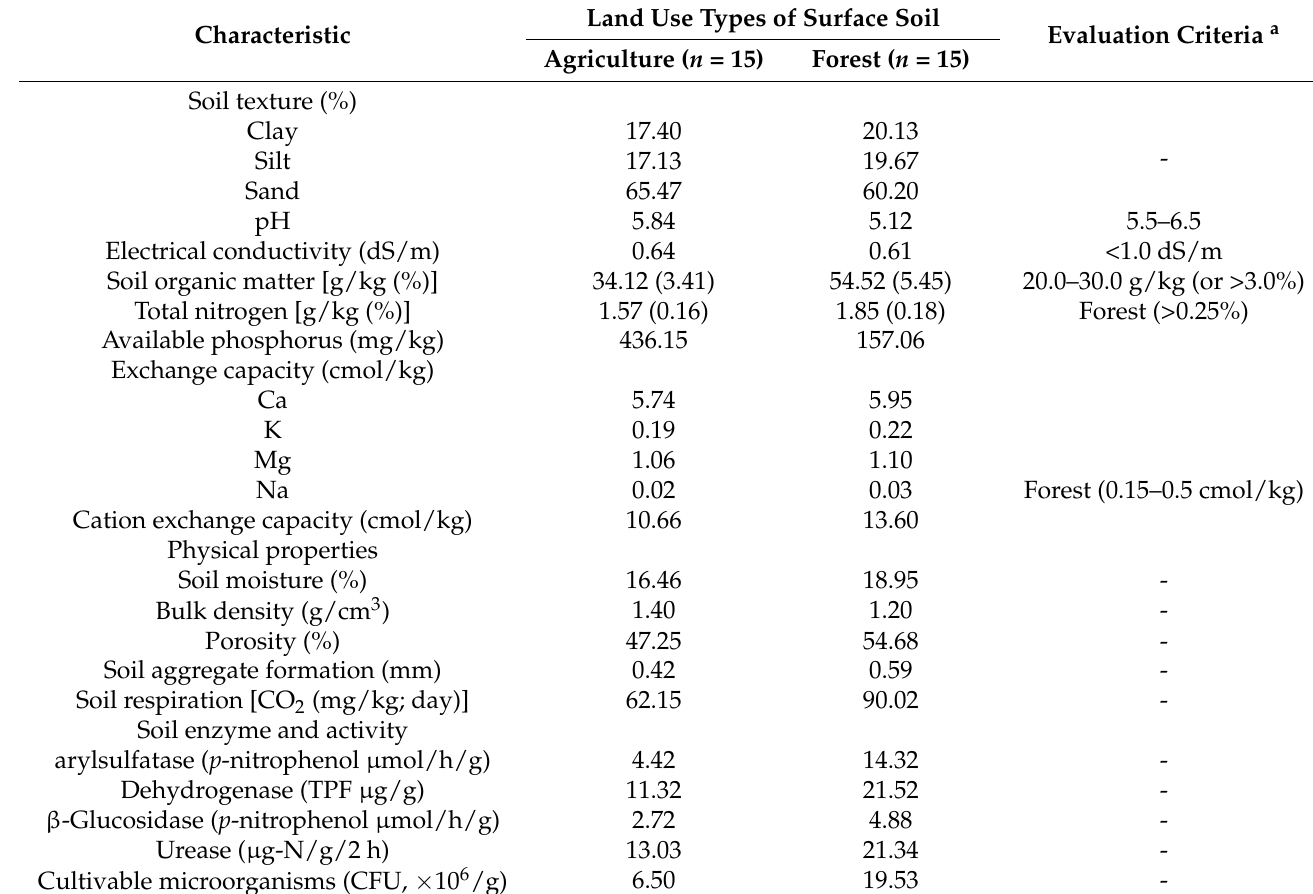
Table 1. Characteristics of surface soil with agriculture and forest as land use